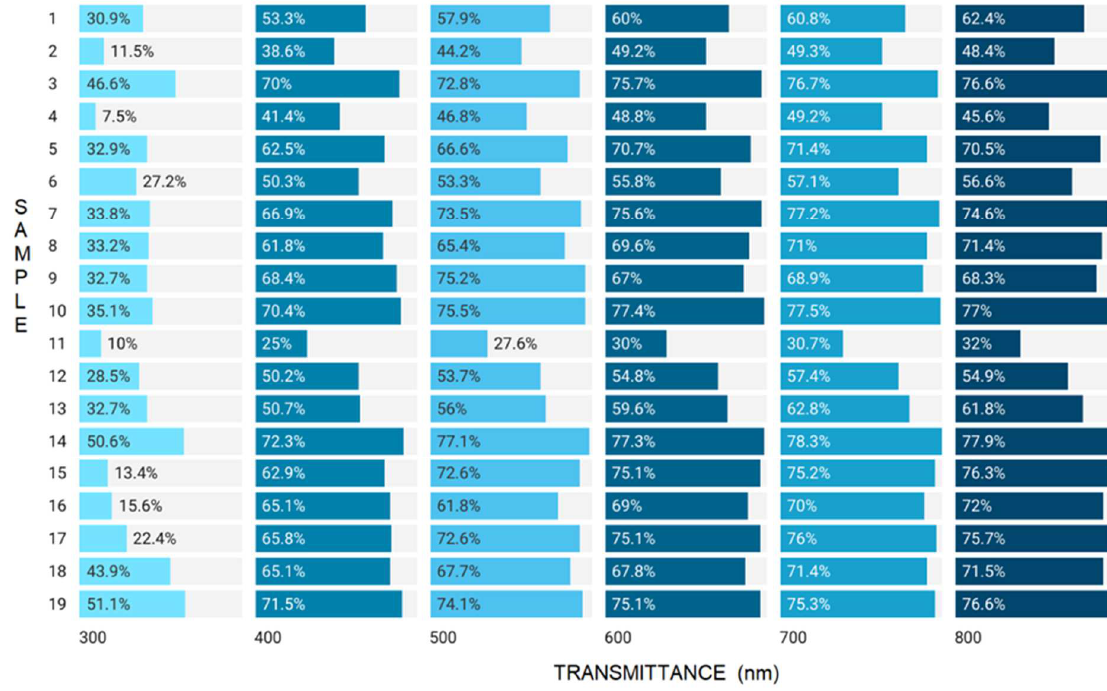
Figure 3. Transmittance values of samples (t0). As depicted in Figure 3, the transmittance values increased within 300–700 nm range. At 800 nm (visible light), films with 7.5% lemon (1), 15% cinnamon (8), 7.5% mint (11), 7.5 and 15% ginger (15,16), 15% eucalyptus (18) EOs and the control (19) exhibited increased transmittance, whereas in the remainder of the films, the transmission was decreased. This determination is important because it evaluates the ability of the material to resist UV radiation can degrade the incorporated product and even the foil, especially when it con- tains essential oil. The smallest variations were observed in the control sample (19) both before and after storage. After storage, the films were more resistant to the action of UV radiation, an effect strengthened by the increased opacity values after storage (Table 1).